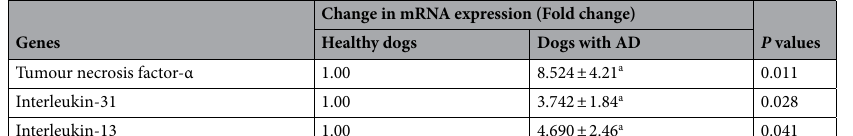
Change in mRNA expression (Fold